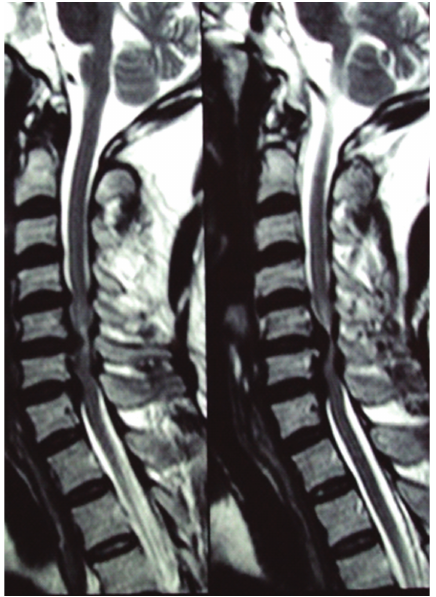
Figure 1: Sagittal MRI image showing C4-C5, C5-C6, C6-C7 disc herniation with caudal migration behind the vertebral body.